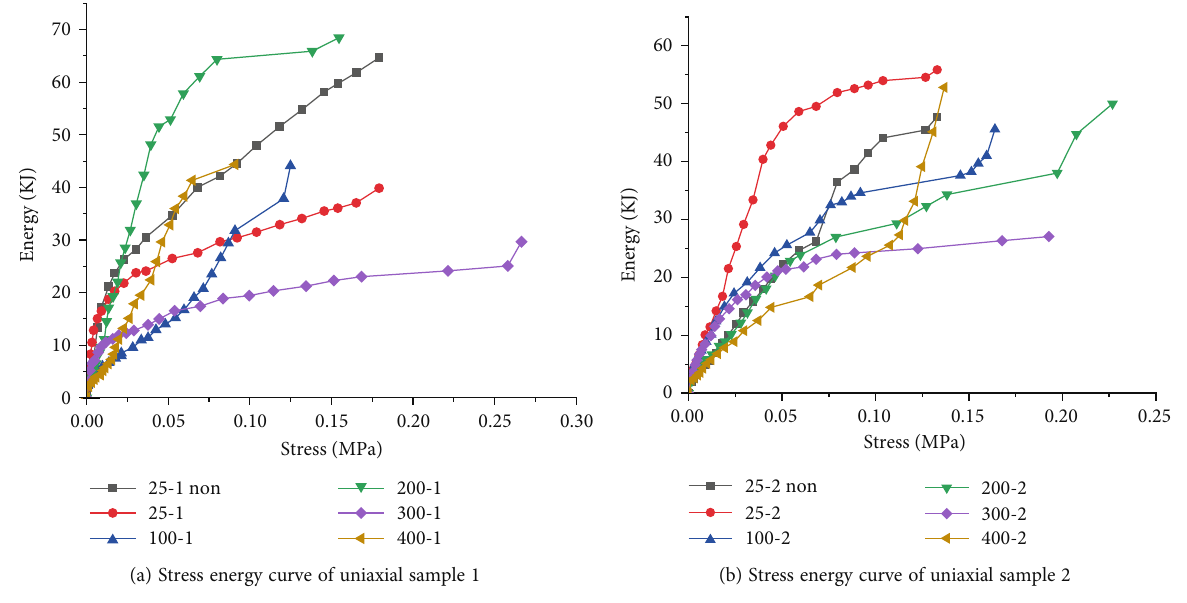
Figure 12: Stress energy curve of uniaxial compression test.